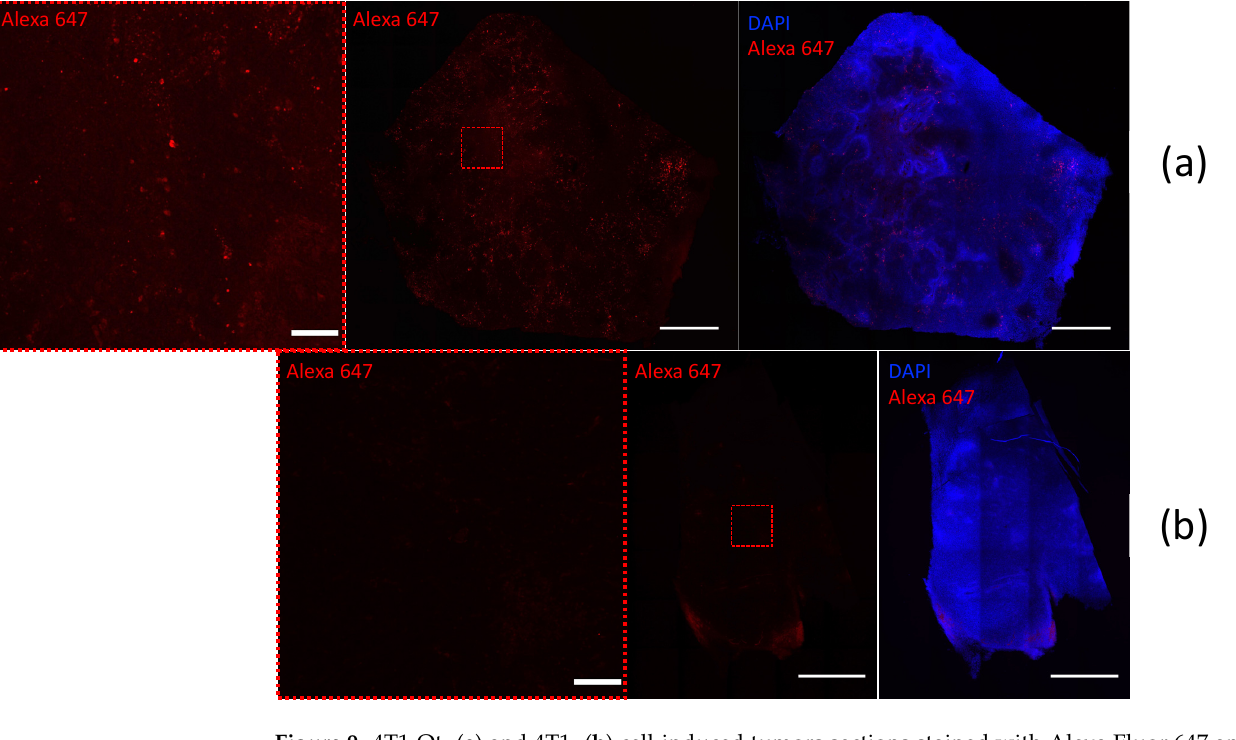
Figure 8. Tumor growth dynamics after subcutaneous implantation of wild-type 4T1 and 4T1-Qt cells. The data are shown as the mean + S.E.M.